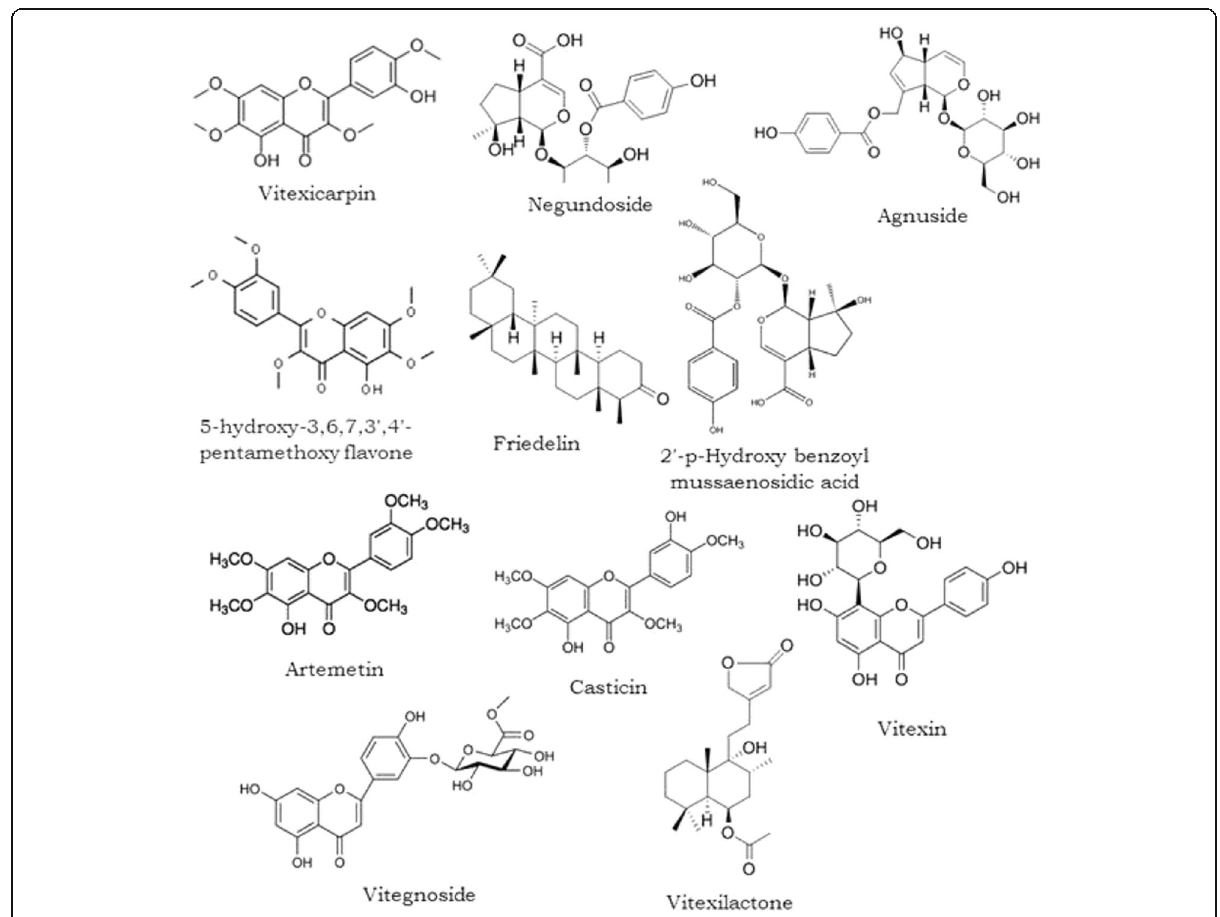
Fig. 3 Phytochemicals present in V. negundo